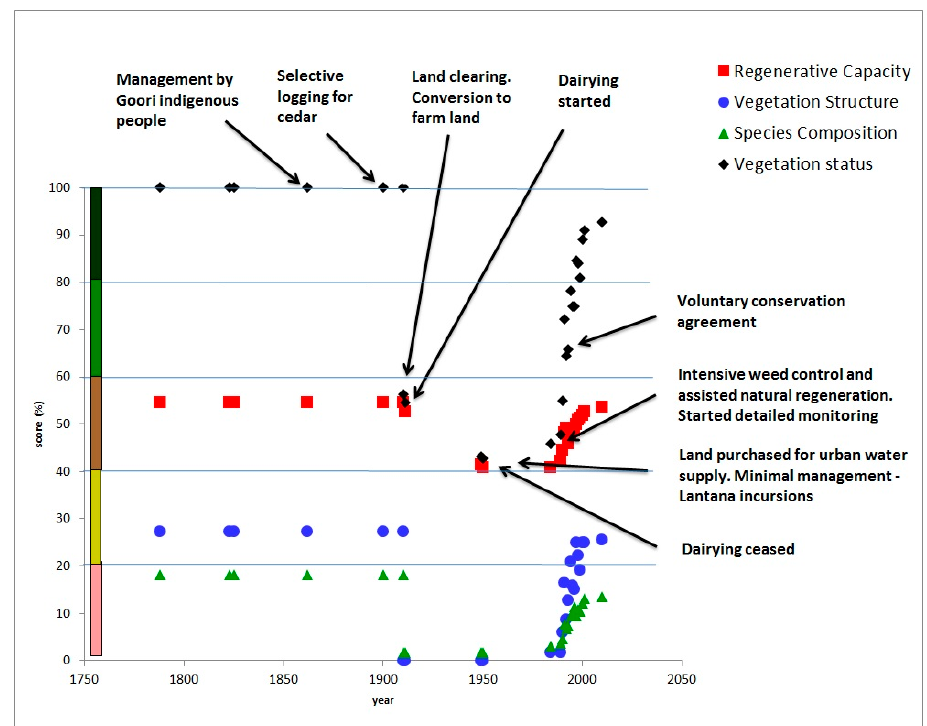
Figure 6. Case study 5: Potters Flat, Wandoan, sub-tropical sub-humid agro-climate region, Acacia open forest and woodland.